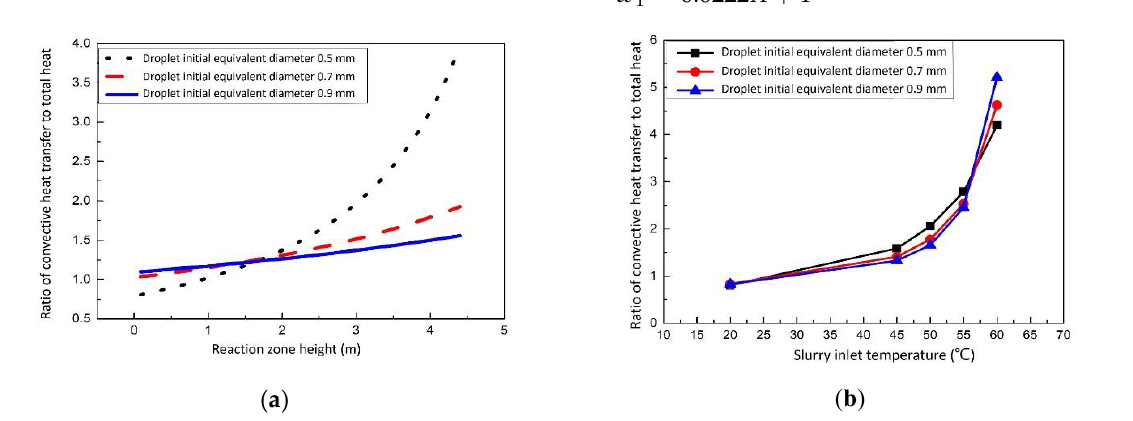
Figure 4. Ratio of convective heat transfer to total heat of flue gas and slurry. ( a ) Effect of reaction zone height on the ratio of convective heat transfer to total heat. ( b ) Effect of slurry inlet temperature on the ratio of convective heat transfer to total heat.